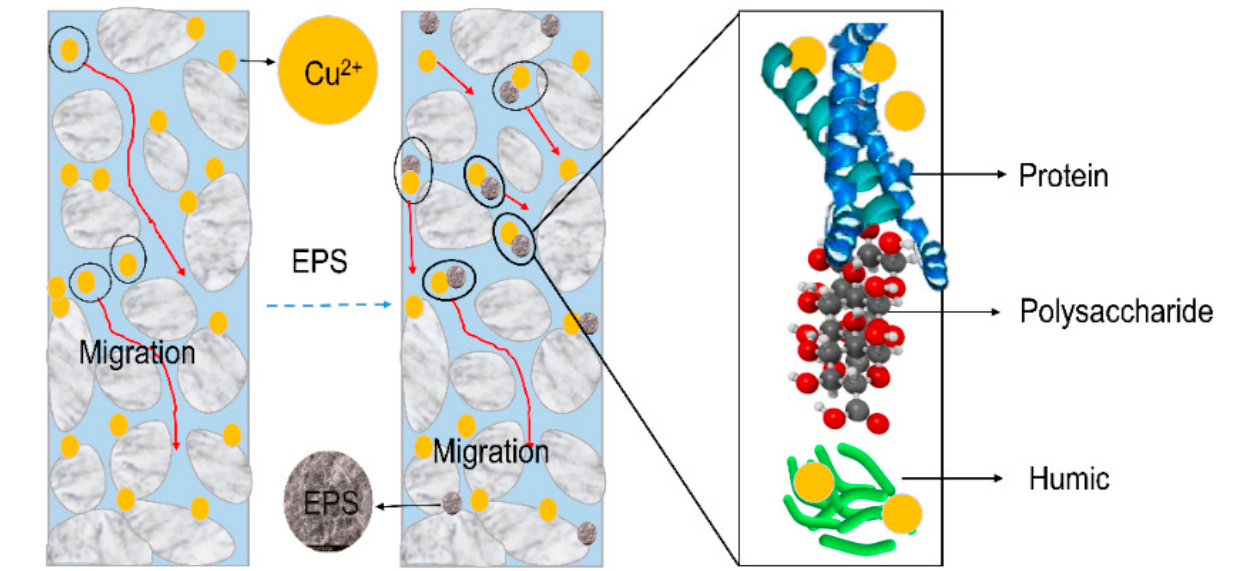
Figure 6. Schematic representation of Cu migration mechanism in saturated porous strata.